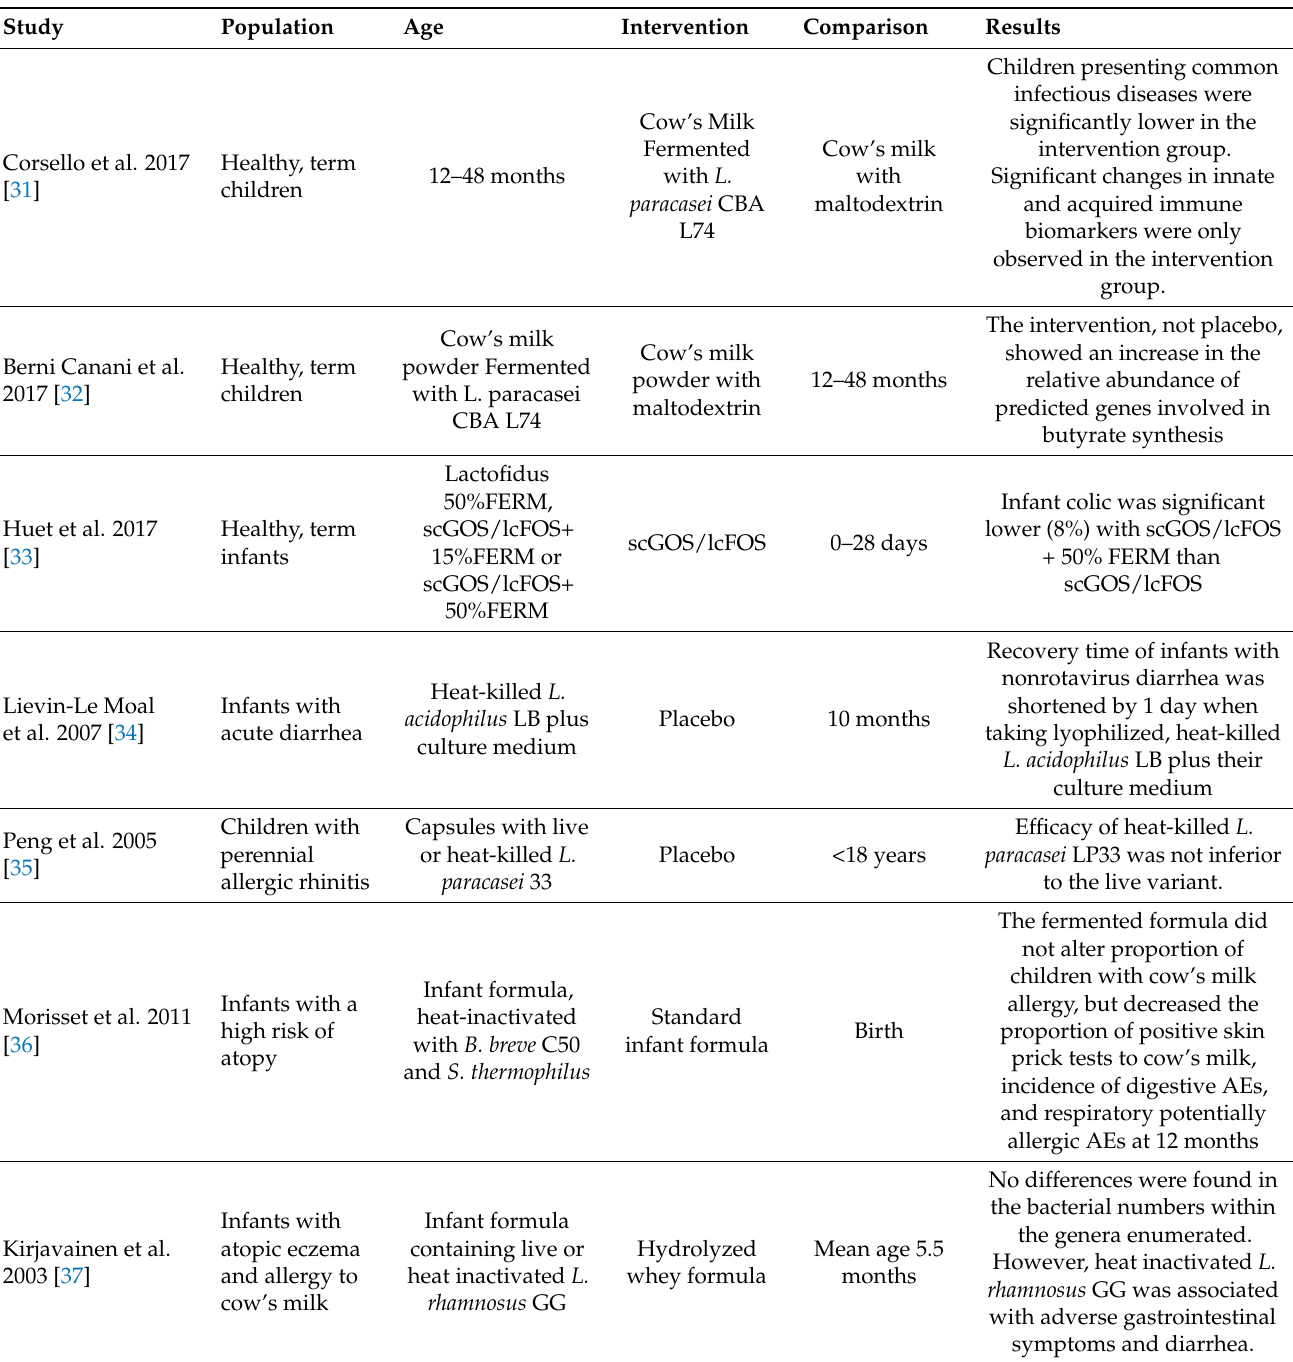
Table 1. Main populations and conditions explored in postbiotics interventions studies in early life stages (Wegh et al., 2019) [30].